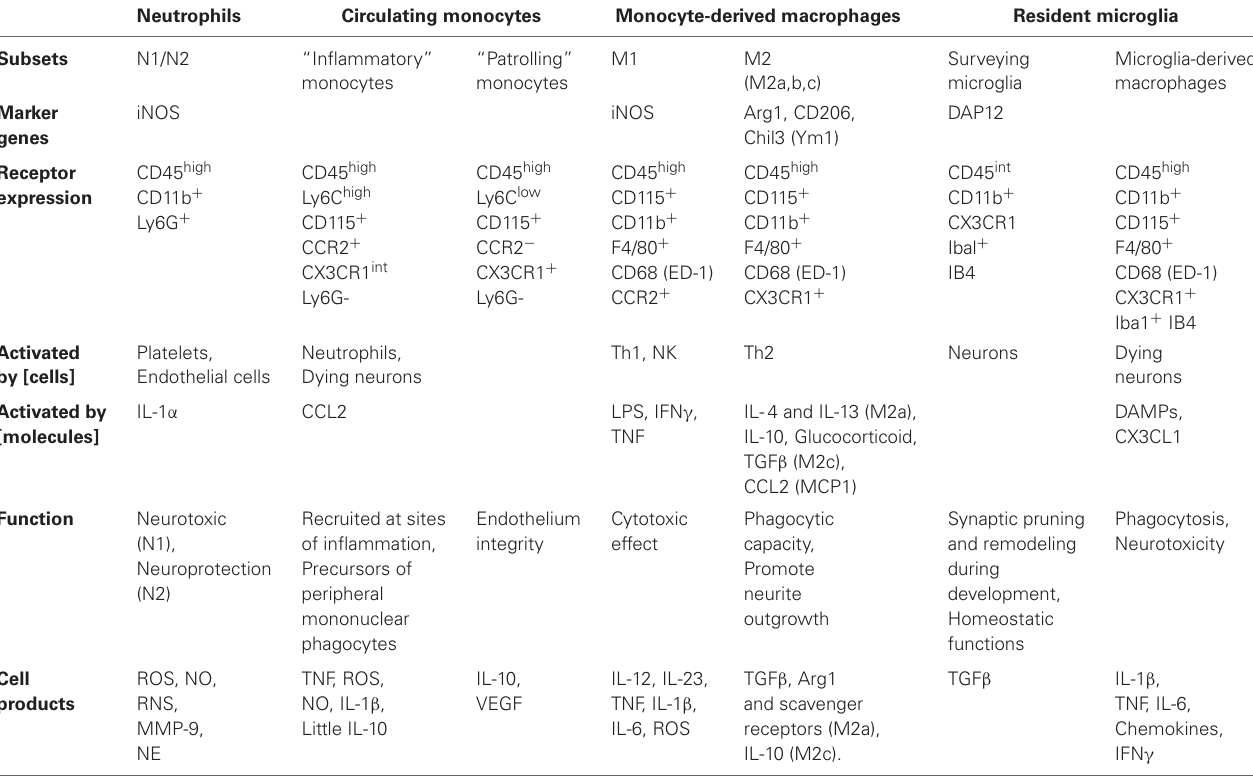
Table 1 | Different activation states of neutrophils, circulating monocytes and tissue macrophages in mice